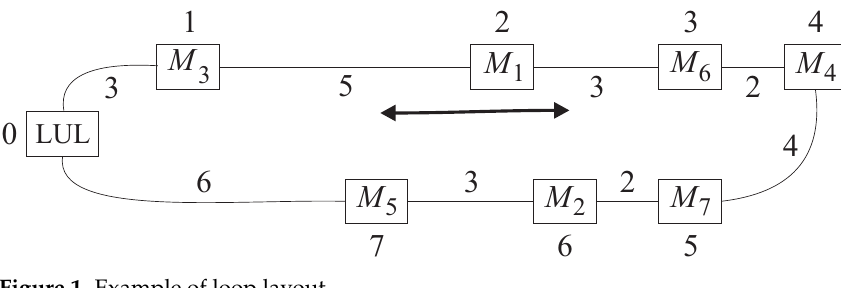
Figure 1. Example of loop